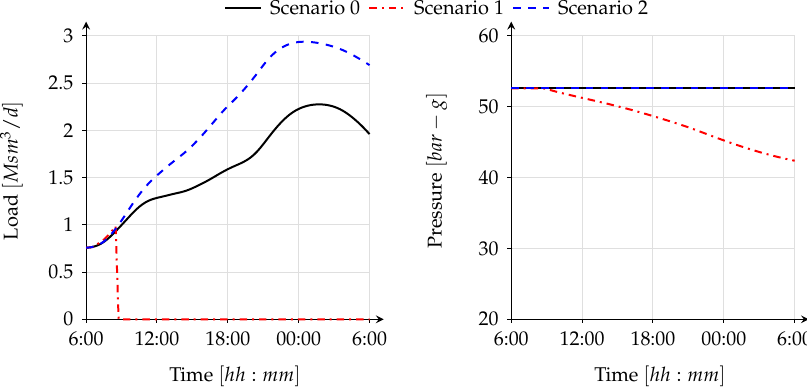
Figure 9. Time evolution of gas supply and pressure at the production field for the computed scenarios.